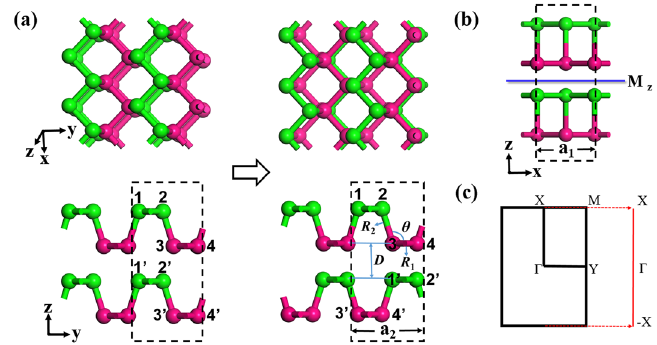
Figure 1. ( a ) (left panels) Top and side views of the bilayer BP, in which the top layer is stacked vertically on the bottom layer. (right panels) Top and side views of the bilayer BP we study, in which the bottom layer is shifted by 1/2 unit cell along the x and then y directions with respect to the top layer. In the built structure, the 1 and 2 atoms in the top layer are above the 3 ′ and 4 ′ atoms in the bottom layer, respectively. ( b ) The other side view (in the xz plane) of the built bilayer BP, owning an M z mirror symmetry. The green and magenta colors in ( a , b ) indicate the top and bottom P sublattices in the nonplanar monolayer BP. ( c ) The 2D first Brillouin zone and the projected 1D Brillouin zone of the bilayer BP we build.